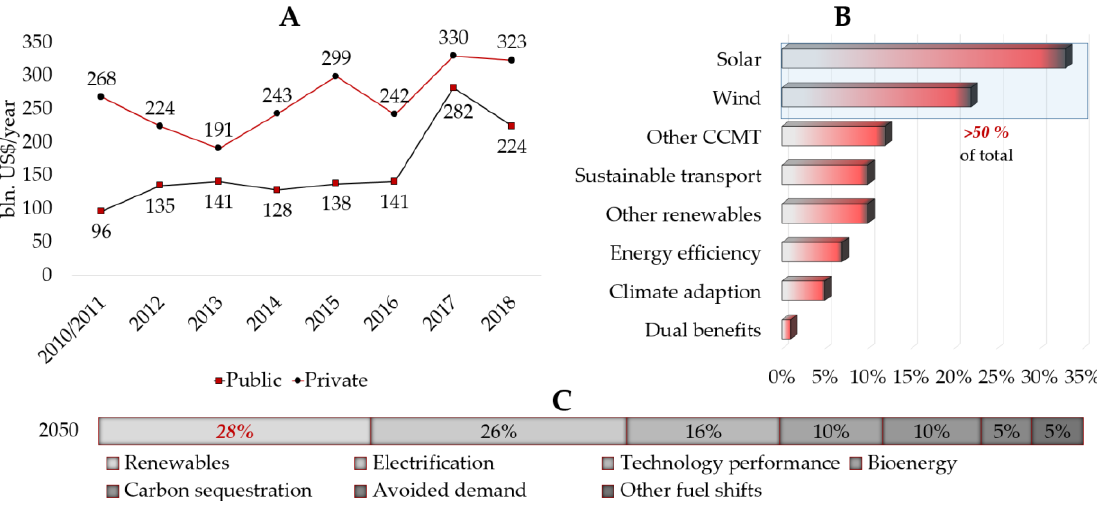
Figure 1. Total global climate change expenditures ( A ), distribution of climate change expenditures in 2011–2018 ( B ) and CO 2 emissions reductions by measure in 2050, compared to 2019, % of total reduction ( C ). Data from